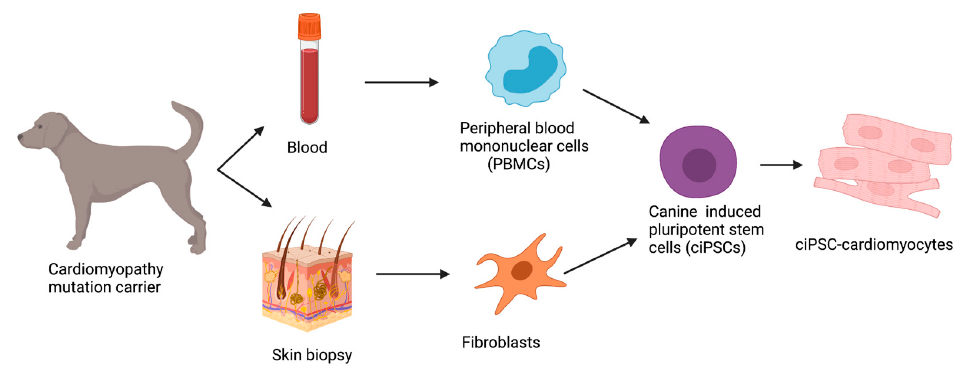
Figure 3. Overview of reprogramming and differentiation methods to create canine induced pluripotent stem cell cardiomyocytes (ciPSC-cardiomyocytes). The ciPSCs can be derived from both whole blood samples and skin biopsies through reprogramming. Following differentiation and expansion into cardiomyocytes, genetic cardiomyopathies can be directly modeled in a dish. Created with BioRender.com.